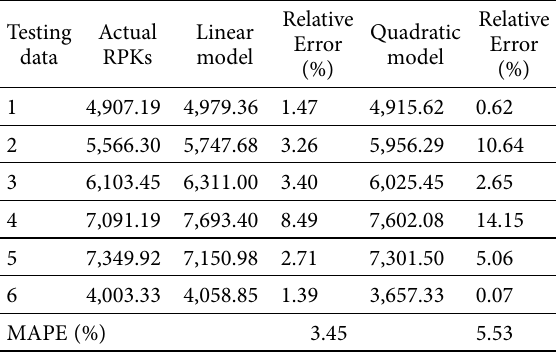
Table 2. A comparison of the GARPKSDE linear and quadratic modelling results with the observed data for the testing period Testing